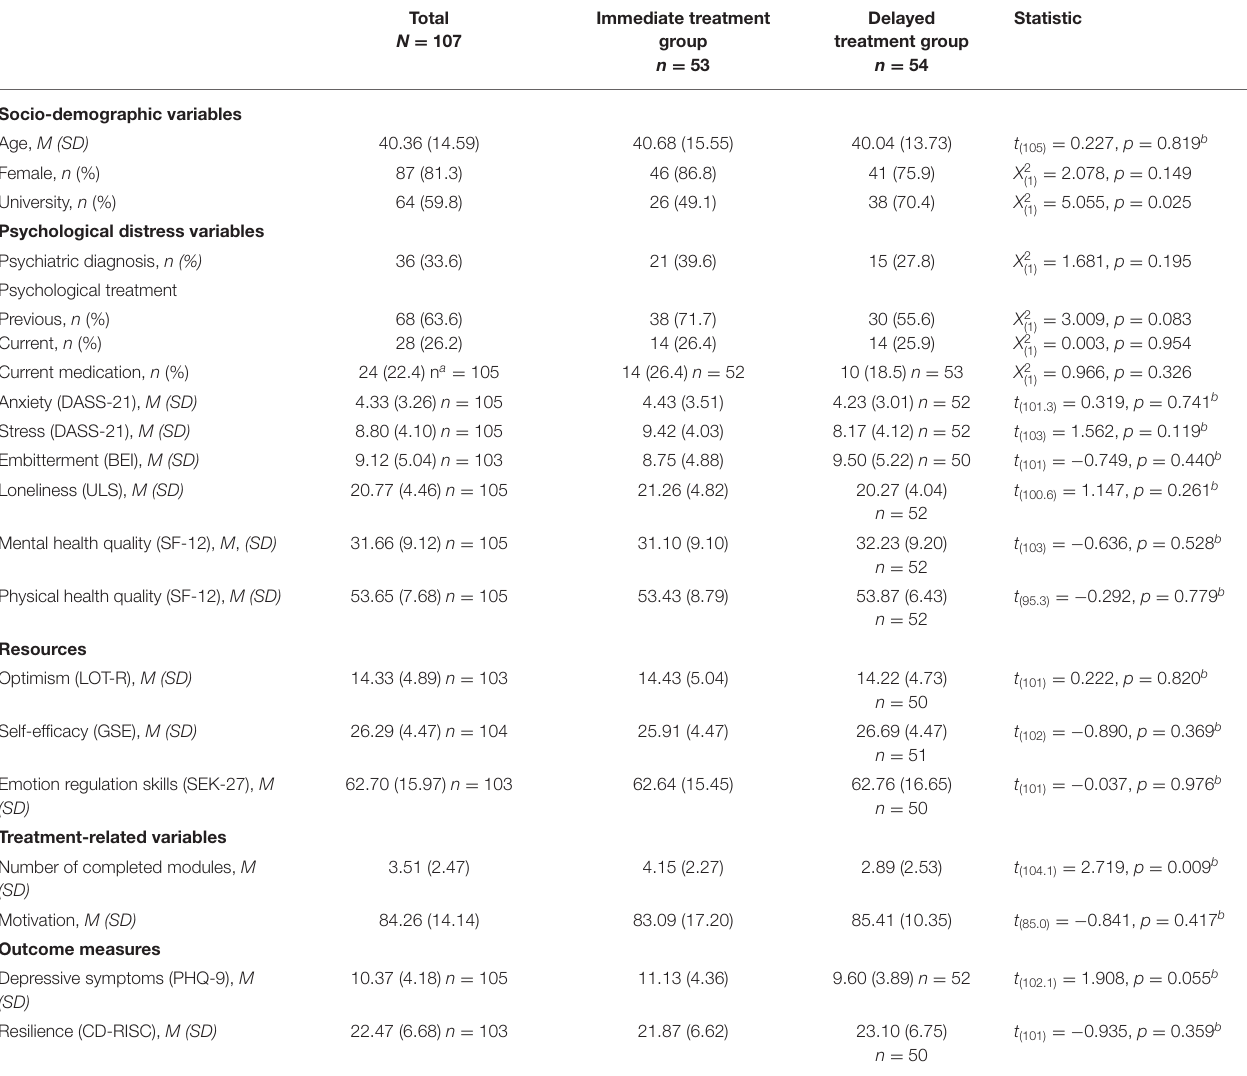
TABLE 1 | Predictors and outcome measures at baseline or pre-treatment, overall and divided by group.